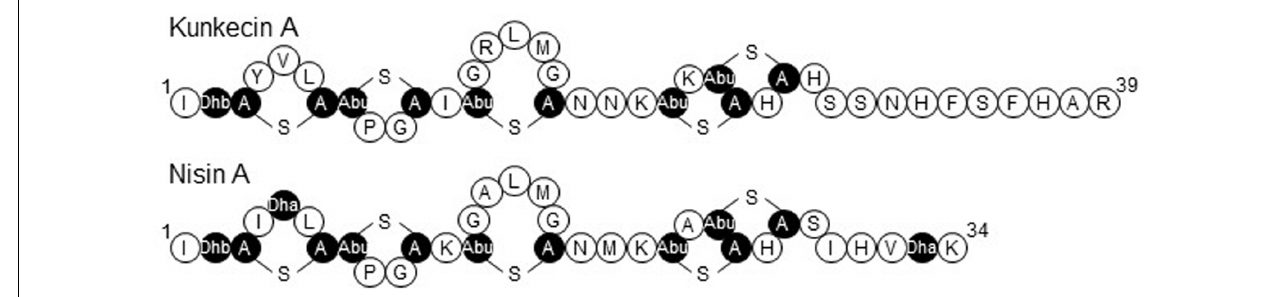
FIGURE 4 | The proposed primary structure of kunkecin A and the primary structure of nisin A. Unusual amino acids generated by post-translational modifications are indicated in black. Dha and Dhb indicate the dehydrated amino acids, dehydroalanine, and dehydrobutyrine, respectively. A-S-A and Abu-S-A indicate lanthionine and 3-methyllanthionine,